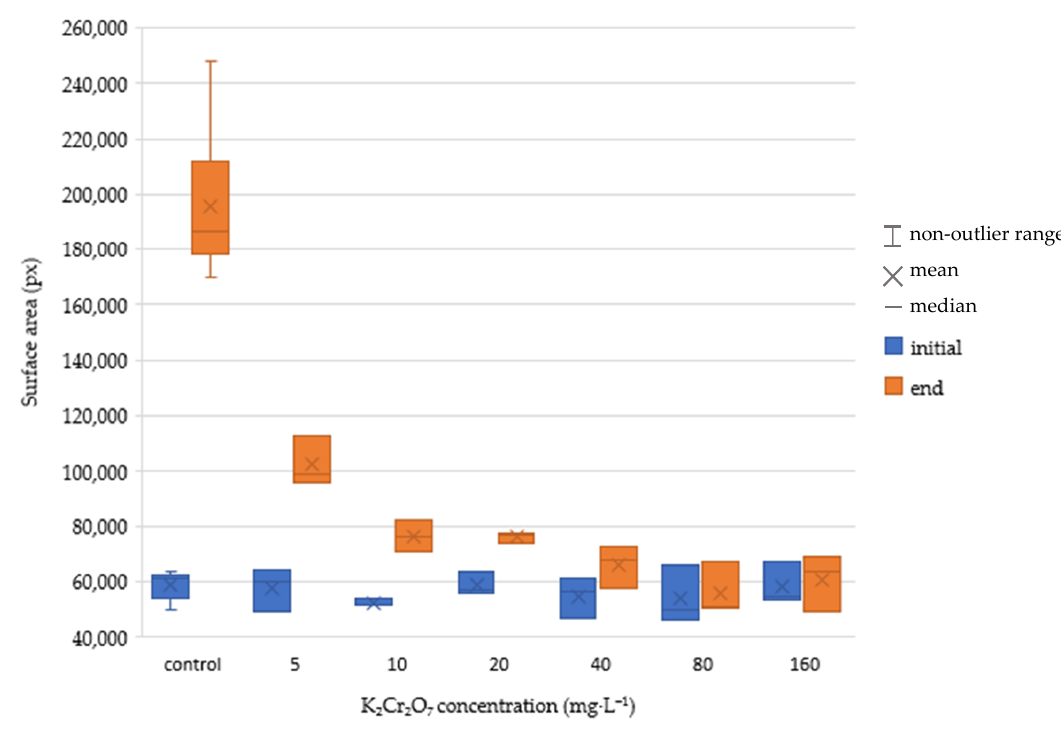
Figure 5 Box and whisker plot of the initial and end area of the Lemna minor leaves.